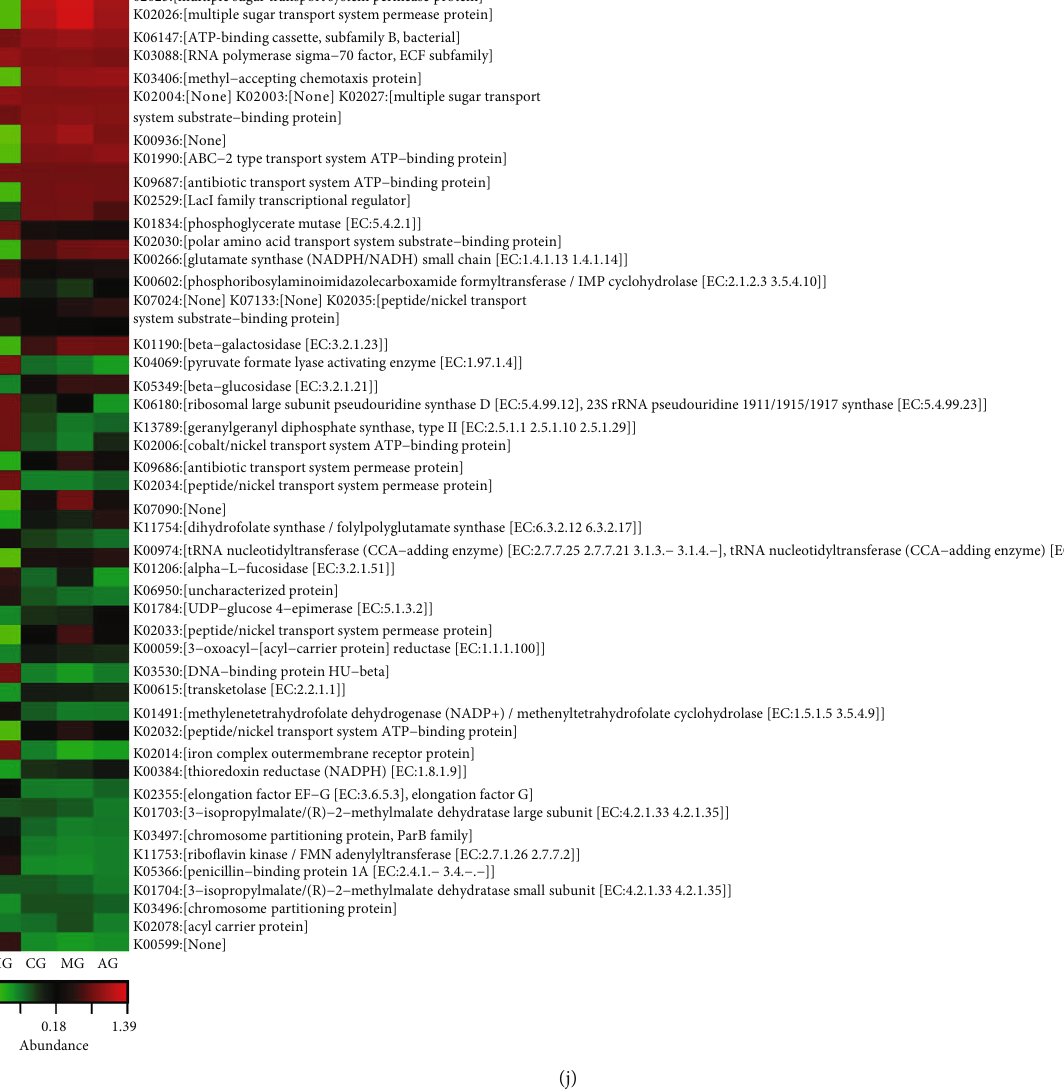
Figure 10: Diversity analysis of gut microbiota among four groups. (a) Shannon ’ s index. (b) Chao1. (c) Simpson ’ s diversity index. (d) Principal coordinate analysis (PCoA) plotted with Bray-Curtis. (e) PCoA plotted with Jaccard. (f) Rank abundance curve. (g) Venn diagram. (h) Circos collinearity plot. (i) The dendrogram of the taxonomic system of all groups at a genus level. (j) Function analysis. The di ff erences in the abundance of di ff erent groups on a branch are compared, which are presented by a colored pie chart. Di ff erent colors represent di ff erent groups, and the larger the fan-shaped area of the color shows, the higher the abundance of the species in the speci fi c group on the branch. Near the fulcrum are the taxonomy name and its corresponding average abundance